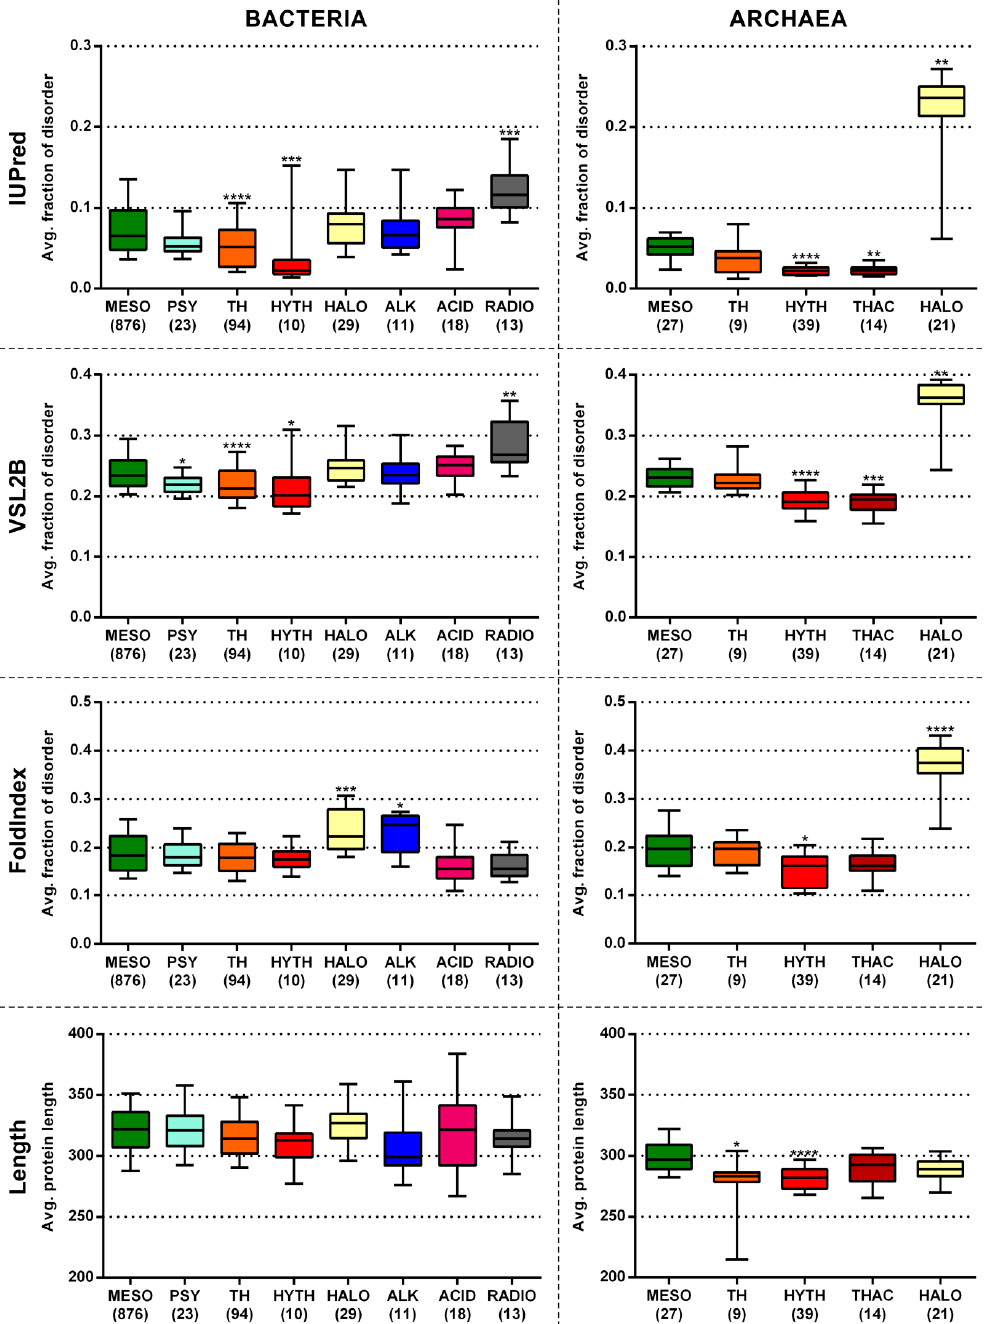
Figure 2. Predicted disorder content of Bacteria and Archaea with different lifestyles. The average fraction of disordered residues was calculated for each proteome by three prediction methods. The distribution of the calculated values of each lifestyle group was compared to that of mesophiles by Dunn’s multiple comparison test for Bacteria and Archaea separately. The significance levels of the distribution differences are indicated as stars above the boxes (* p < 0.05; ** p < 0.01; *** p < 0.001; **** p < 0.0001). The number of proteomes in the different lifestyle groups are indicated below the labels.